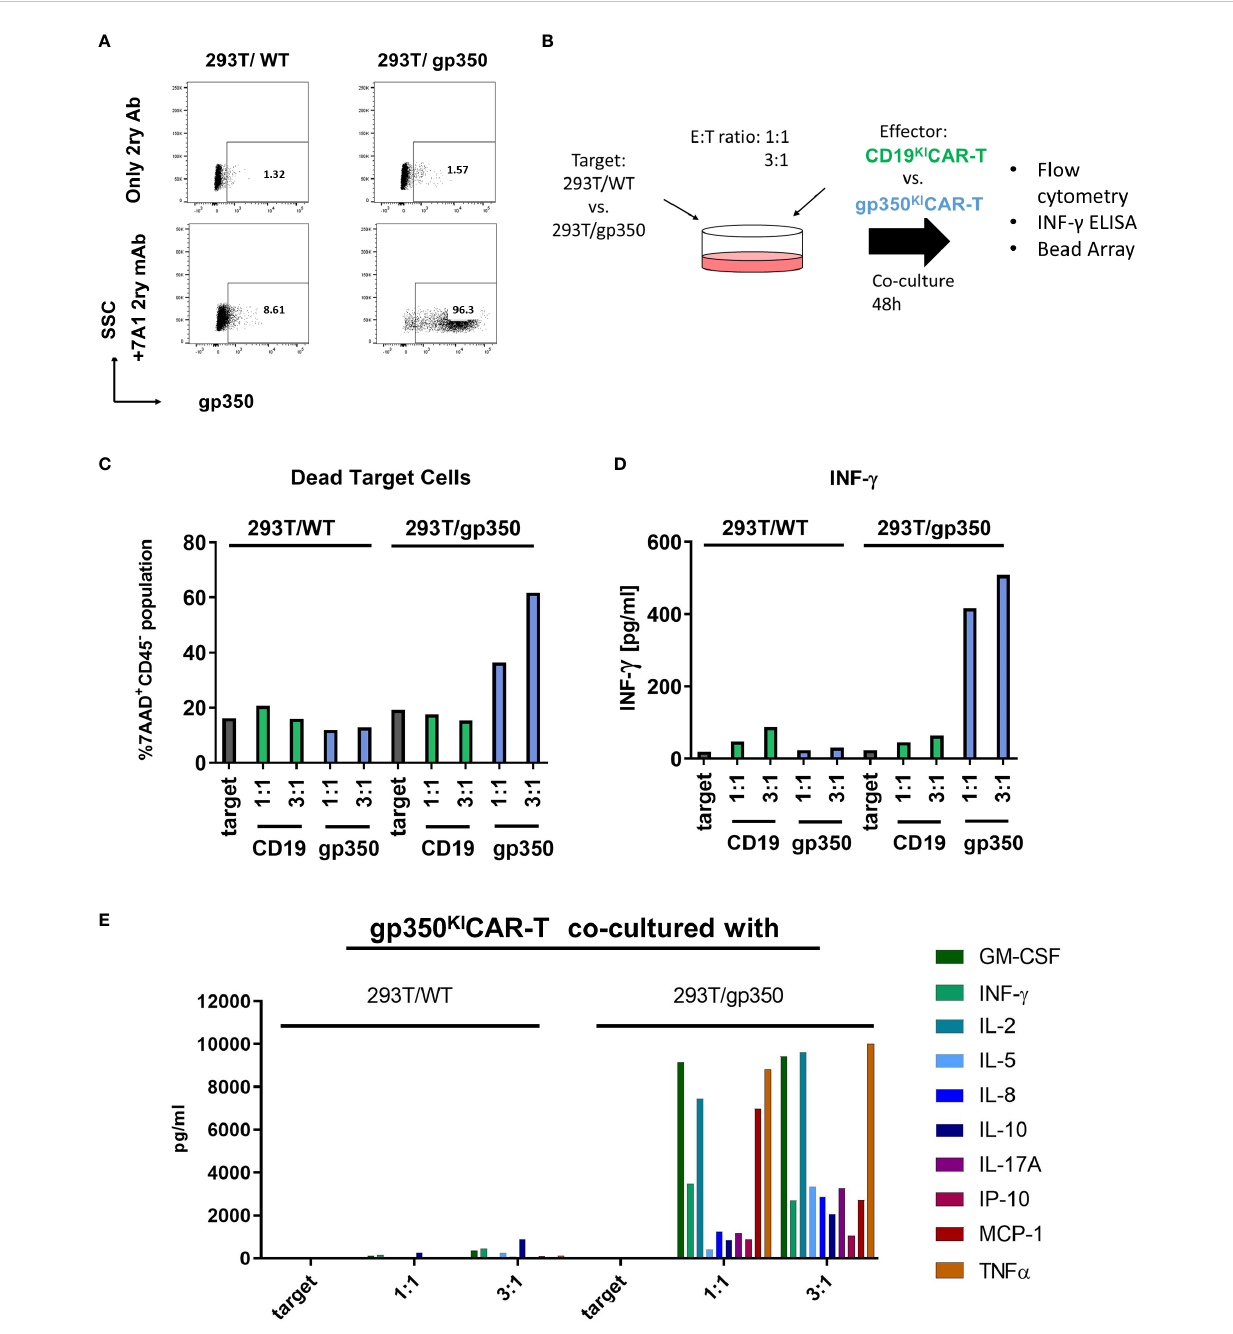
FIGURE 2 Speci fi c recognition of gp350 on the cell surface by gp350 KI CAR-T cells. (A) Flow cytometry analyses of gp350 expression on the cell surface of 293T/WT and 293T/gp350 cell lines. Upper panels show cells stained only with the immune-conjugated secondary antibody. Lower panels show cells stained with the primary 7A1 monoclonal antibody and the secondary antibody. (B) Schematic representation of analyses of gp350 KI CAR-T cell speci fi city after co-culture with 293T/WT or 293T/gp350 cell lines at different effector-to-target (E:T) ratios. After 48 h of co-culture, the dead cells were detected by fl ow cytometry, and cytokines secreted in the medium supernatant were analyzed. (C) Quanti fi ed proportions of dead target cells. (D) Secreted IFN- g (pg/ml) and (E) several cytokines detected in cell supernatants (pg/ml) after co-cultures at 1:1 and 3:1 E:T ratios. Data obtained with CD19 KI CAR-T cells with gp350 KI CAR-T cells are depicted in green and blue, respectively. The results represent a single